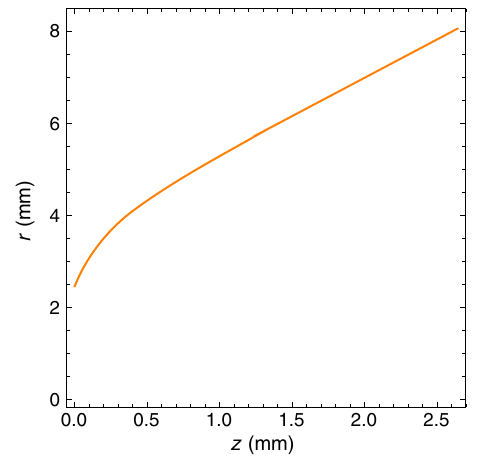
FIG. 6. Surface profile of the mirror.